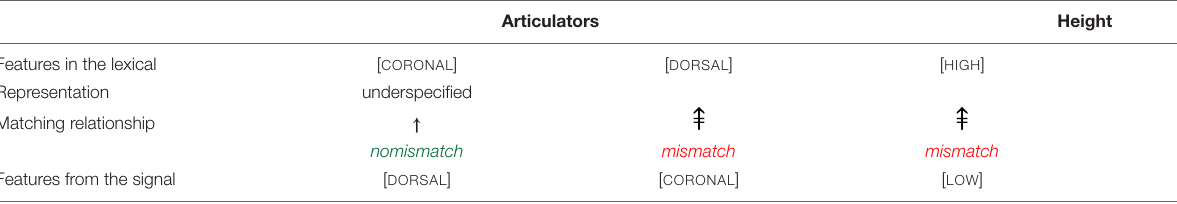
TABLE 1 | The mismatching and matching relationships in the study by Kotzor et al. (2020).